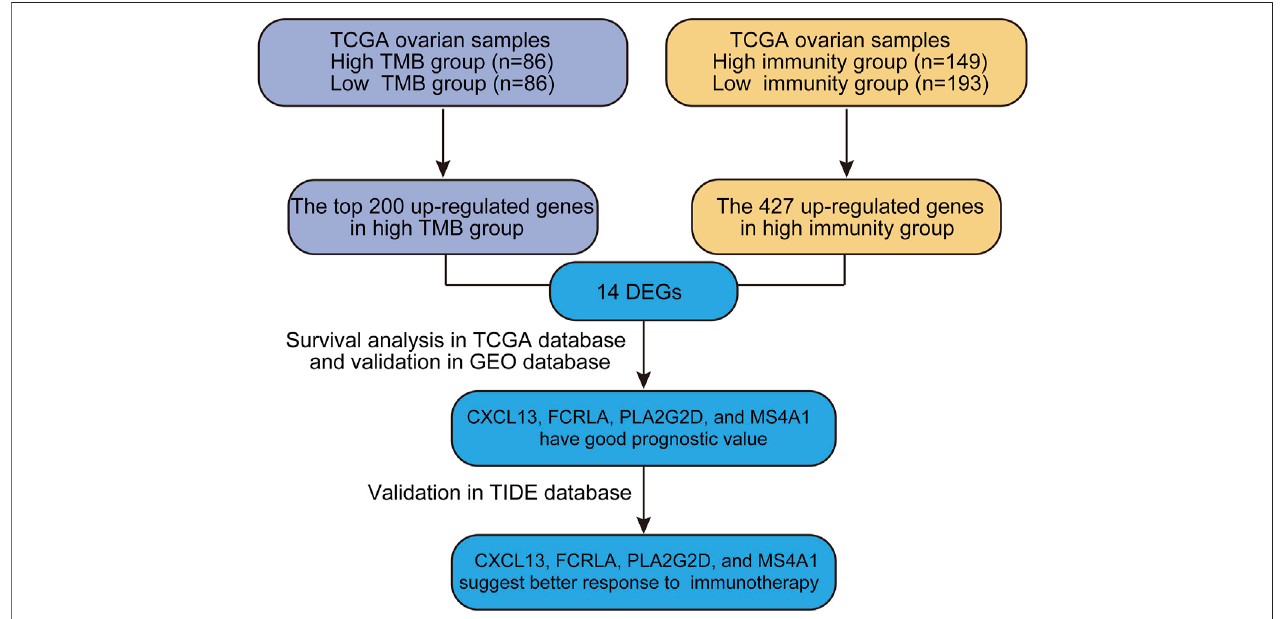
FIGURE 1 | The work fl ow of the current